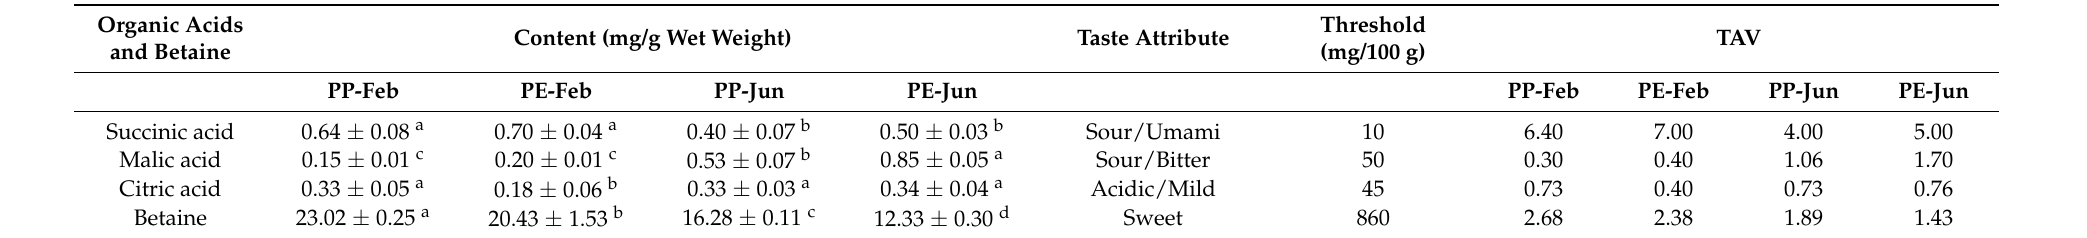
Table 8. The concentrations, taste thresholds, and TAVs of organic acids and betaine of two P. f. martensii selective strains at different seasons. Organic